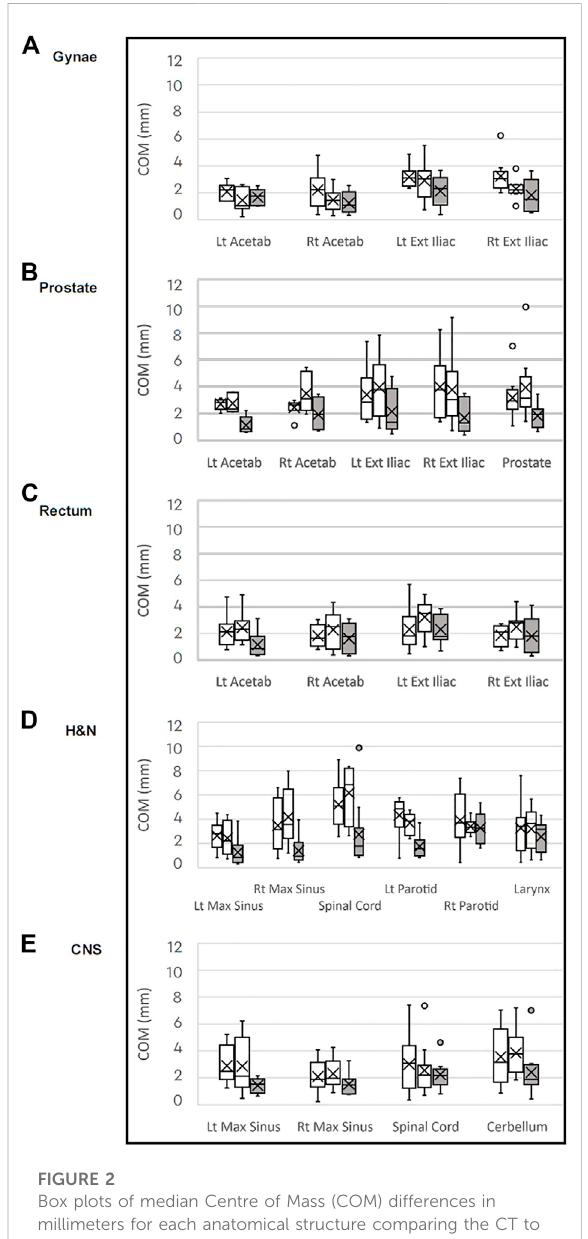
millimeters for each anatomical structure comparing the CT to MRI datasets (white) and MRI to MRI (grey) for the (A) gynaecological; (B) prostate; (C) rectal; (D) H&N: and (E) CNS patient groups.